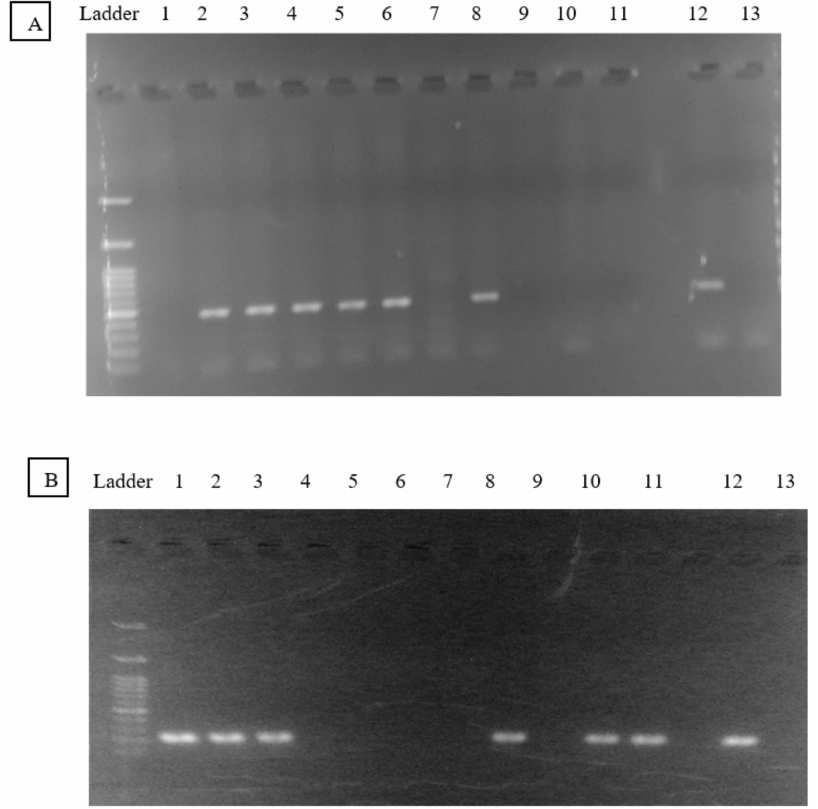
Figure 1. PCR products revealed using 1.5% agarose gel electrophoresis. The bands were 215 and 480 bp in size, depending on the GST genotype, designated as GSTT1 ( A ) and GSTM1 ( B ). Samples are 1–11, 12 positive amplification sample and 13 negative amplification